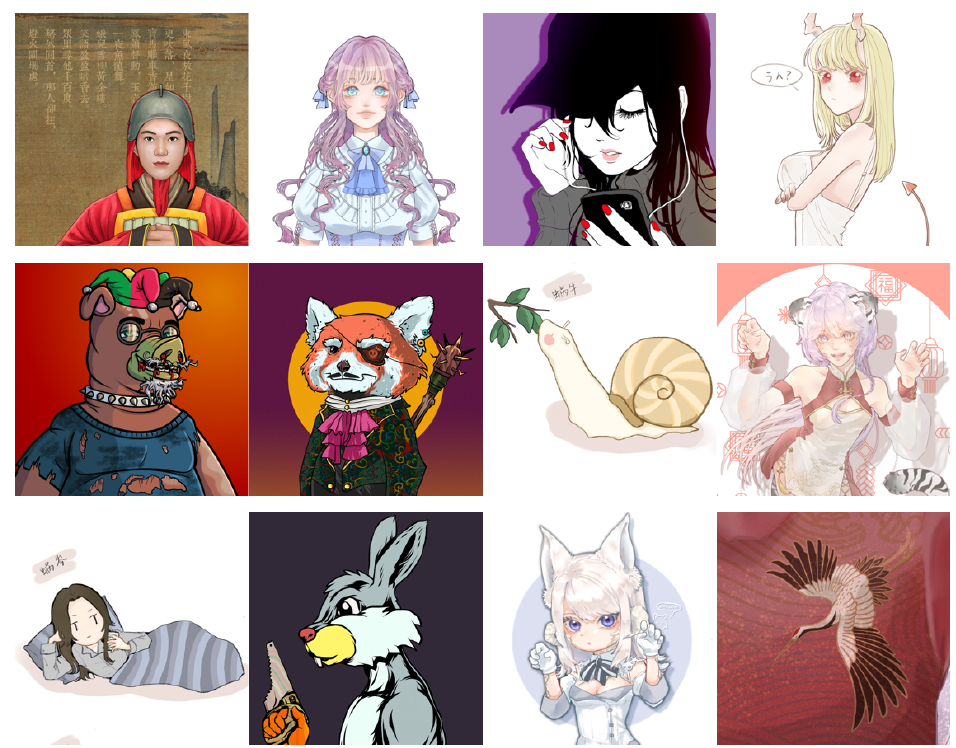
Figure 19. Example images from the Multi-level anime83 dataset. HR is 1024 × 1024, LR are 128 × 128, 256 × 256, 512 × 512. The images are adopted from